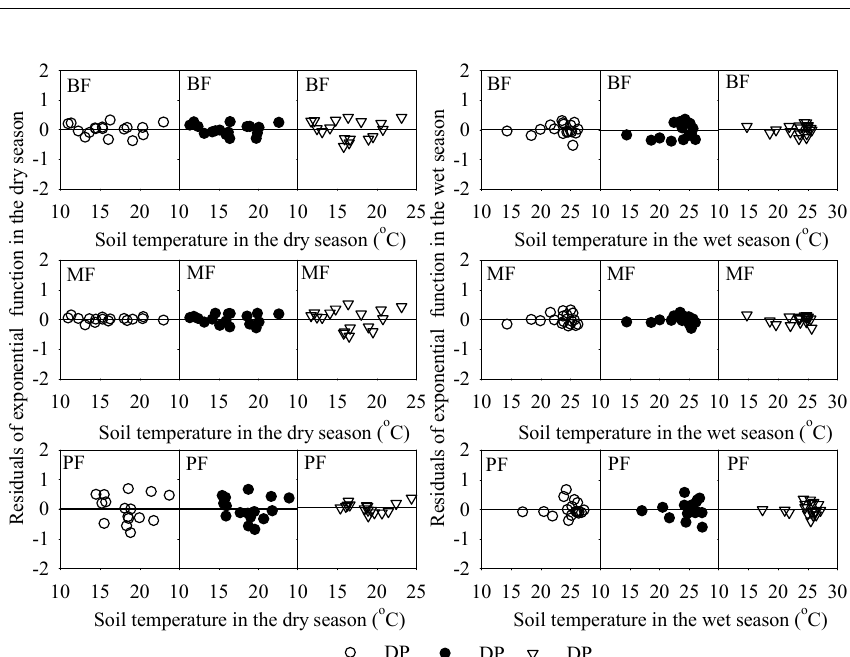
Fig. A3. Residual plots for the models of soil respiration rate ( R , µmolCO 2 m − 2 s − 1 ) and soil temperature at 5cm depth ( T , ◦ C) (exponential equation: R = R 0 exp (b 0 T ) ) under different seasons and different precipitation treatments at the DNR forests. The treatments are as follows: precipitation exclusion (EP), ambient precipitation (AP), and double precipitation (DP). The forests are as follows: broadleaf forest (BF), mixed forest (MF), and pine forest